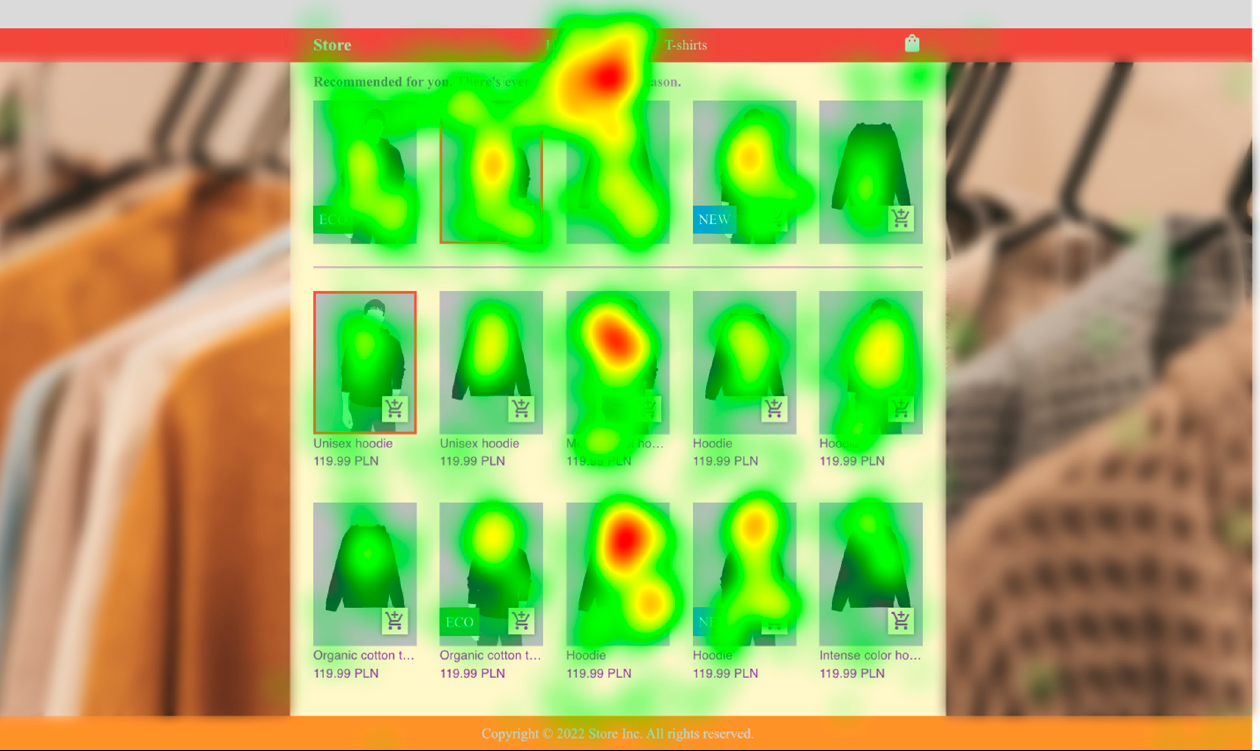
Figure 7. Aggregated heatmap of all participants for the first category (hoodies or skirts) in the unsightly store. (The pictures of clothes and models are illustrative).